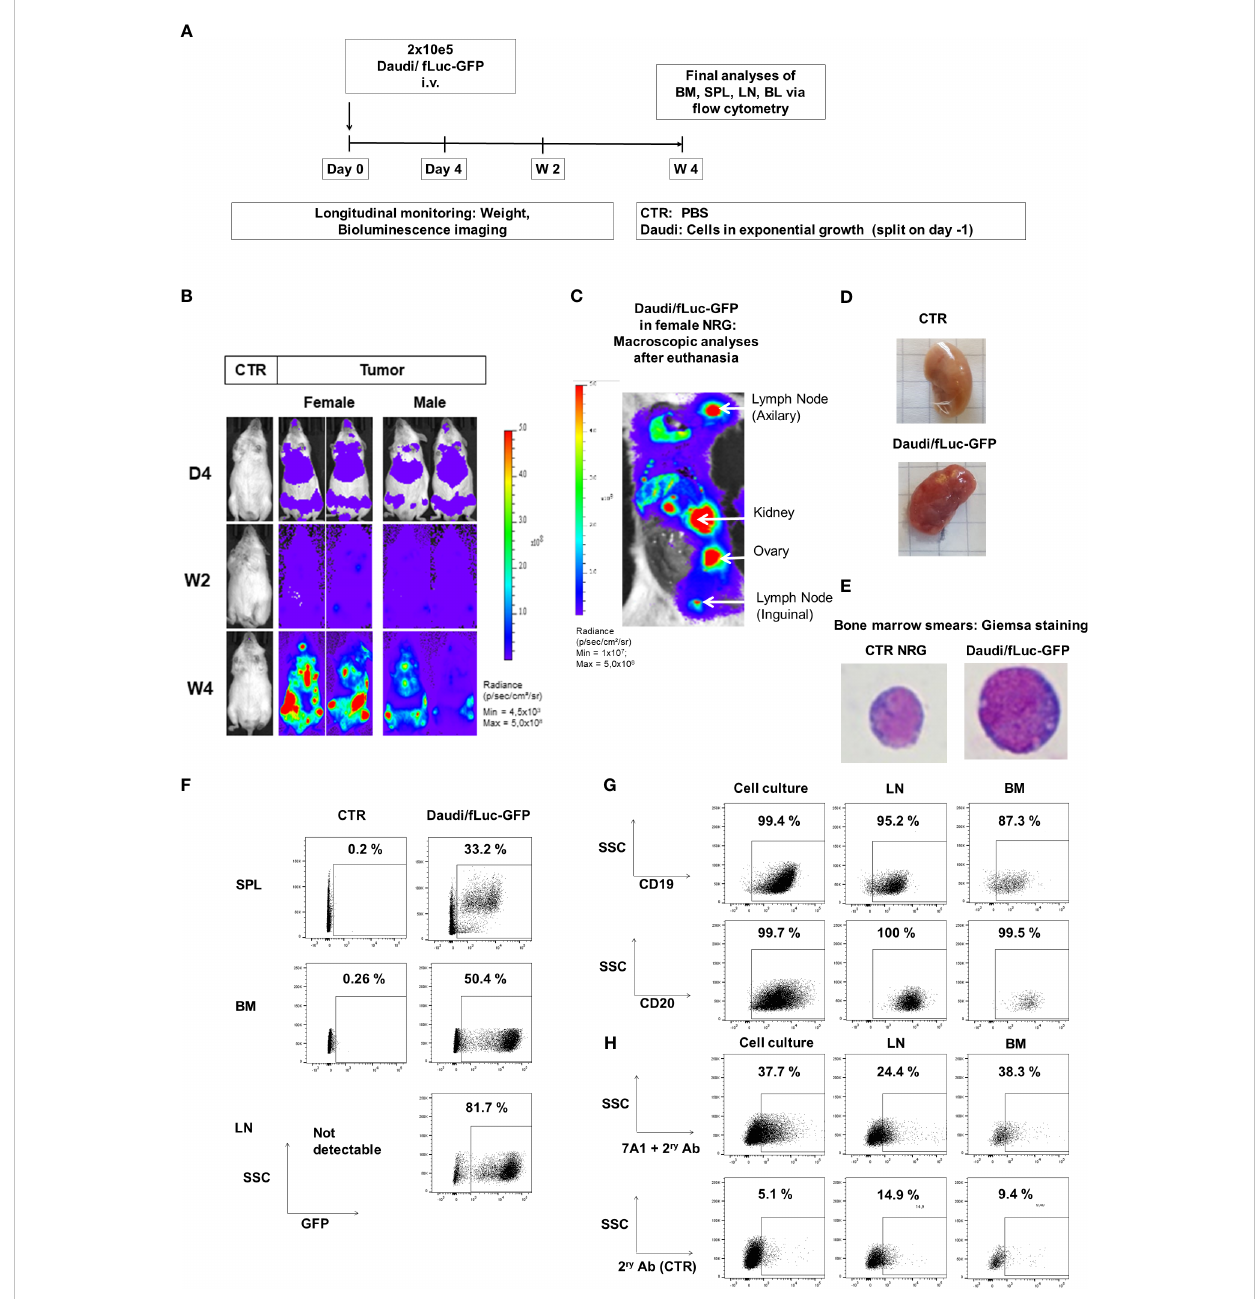
FIGURE 5 Daudi/fLuc-GFP engrafted and disseminated in several organs of mice and maintenance of surface expression of GFP, CD19, CD20, and gp350 in vivo . (A) Experimental scheme. Nod.Rag.Gamma (NRG) mice were challenged with 2 × 10 5 Daudi/fLuc-GFP cells (i.v. injection; females, n = 3; males, n = 3; non-challenged PBS control, CTR, n = 1). (B) Representative examples of two challenged mice (female and male) and a control mouse are shown. Mice were analyzed longitudinally by bioluminescence imaging (BLI) for 4 weeks, and the experiment was then terminated. BLI of control (PBS) and female and male mice is shown at 4 days, 2 weeks, and 4 weeks after challenge (frontal view; scale from 4.5 × 10³ to 5.0 × 10 8 p/s/cm 2 / sr). (C) Post-mortem abdominal BLI of a female mouse developing several lymphoma foci in lymph nodes, kidney, and ovary (scale 1.0 × 10 7 to 5.0 × 10 8 p/s/cm 2 /sr). (D) Images of kidneys, from CTR mouse as a reference and from a mouse developing tumors. (E) Images of bone marrow smears stained with Giemsa. A mouse normoblast was seen in control mice, and cells with typical morphology of lymphoma were observed in a mouse challenged with Daudi/fLuc-GFP cells. Original magni fi cation ×1,000. (F) Flow cytometry analyses of various lymphatic tissues (SPL, spleen; BM, bone marrow; LNs, lymph nodes). GFP expression (shown in the x-axis) was maintained in blasts; 10,000 events are shown. (G) Flow cytometry analyses of Daudi/fLuc-GFP cells maintained in culture or explanted from LNs and BM. GFP + blasts express CD19 and CD20. At least 1,500 events are shown. (H) Flow cytometry analyses of Daudi/fLuc-GFP cells maintained in culture or explanted from LNs and BM. Subpopulations of GFP + CD20 + blasts expressed gp350. The samples were stained with 7A1 primary mAb for gp350 detection and secondary Ab (upper row) or with secondary Ab only (bottom row). At least 1,500 events are shown. Unstained samples were used as references for gating (not